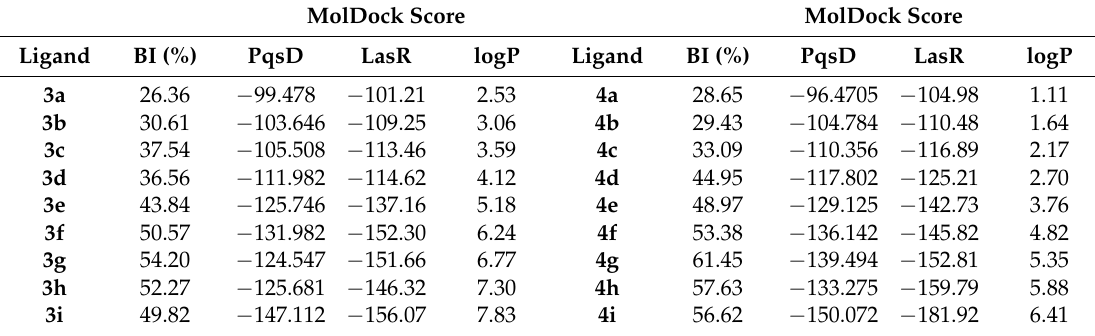
Table 2. Docking scores and c logP values calculated for compounds 3a-i and 4a-i